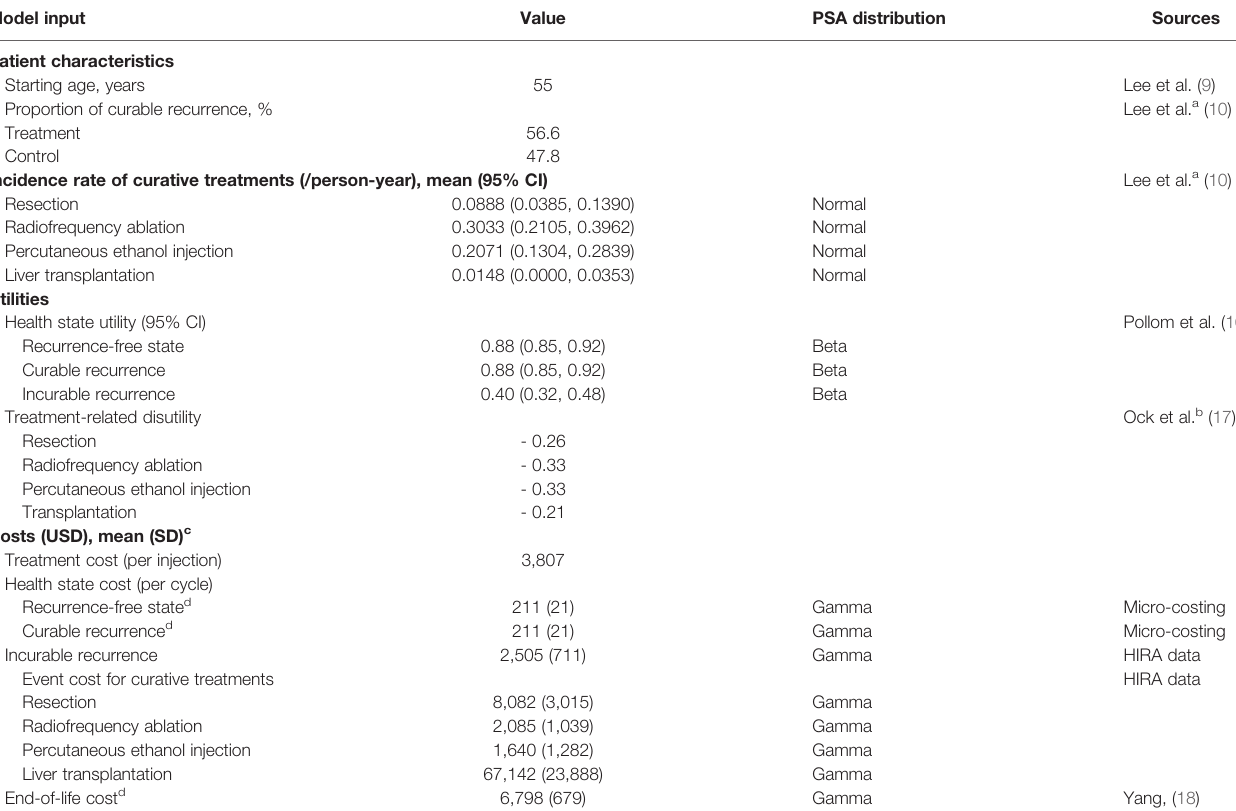
TABLE 1 | Model input